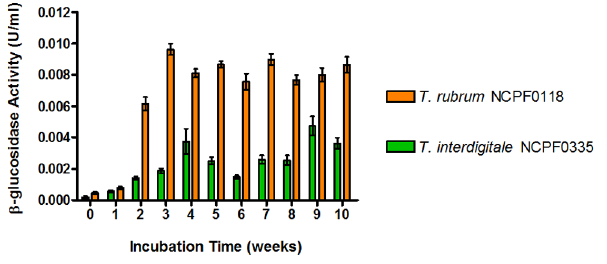
Figure 2. Determination of b -glucosidase activity by T.rubrum NCPF0118 and T. interdigitale NCPF0335 over a 10 week incubation period. b -glucosidase activity was determined from triplicate 100 m l cell pellets, and results are representative of triplicate experiments. Error bars represent the standard deviation of the mean.